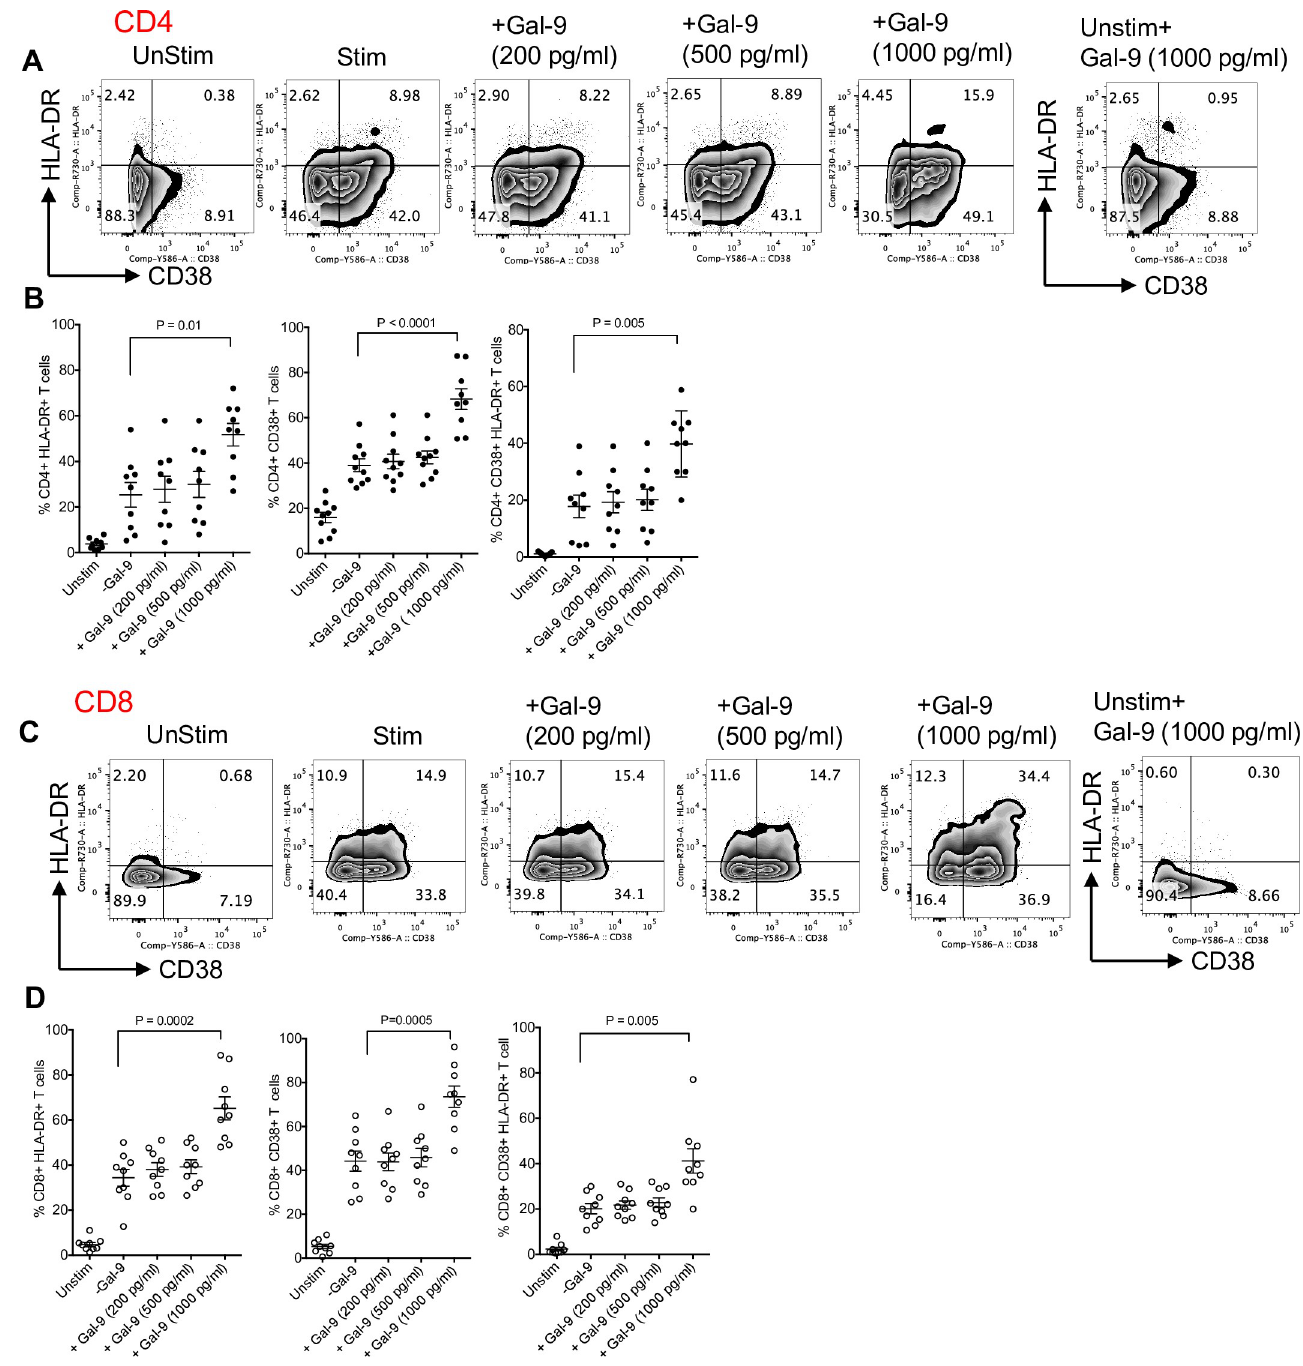
Fig 4. High concentrations of Gal-9 contribute to T-cell activation. (A) Representative flow cytometry plots and (B) cumulative data of percentages of CD4 + T cells expressing CD38, HLA-DR, and both when cultured and stimulated in the absence or presence of exogenous Gal-9 (200, 500, or 1,000 pg/ml) in vitro. (C) Representative flow cytometry plots and (D) cumulative data of percentages of CD8 + T cells expressing CD38, HLA-DR, and both when cultured and stimulated in the absence or presence of exogenous Gal-9 (200, 500, or 1,000 pg/ml) in vitro. The underlying data can be found in S1 Data. Gal-9, Galectin-9.